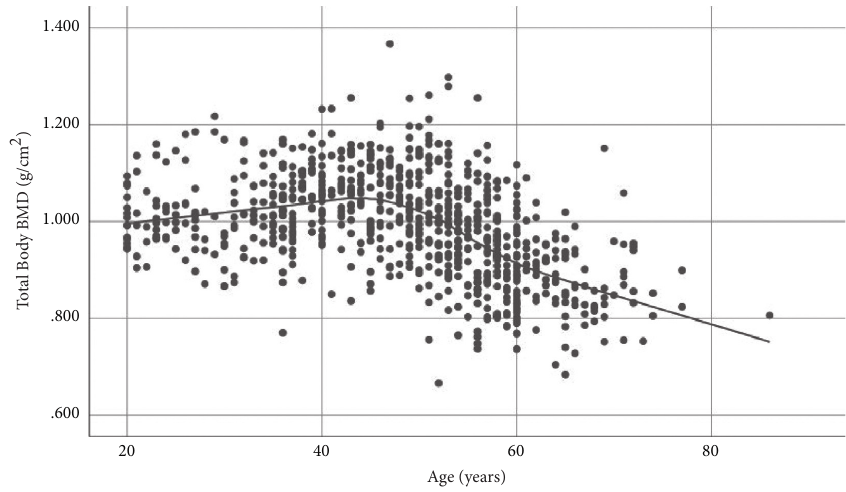
Figure 1: Age-related trend of 2.3. Statistical Analysis. Data were assessed for normality by Kolmogorov Smirnov test. Body composition parameters were expressed as mean (SD) for age groups. Scatter plots of body composition variables were plotted against age and locally weighted scatterplot smoothing lines (Loess) were fitted to observe age-related trends in each variable. Mul- tivariate analysis of variance (MANOVA) with Bonferroni test (post hoc) was used to examine the mean differences between groups. Data were analyzed with SPSS 20.0 version. p values < 0.05 were considered significant.